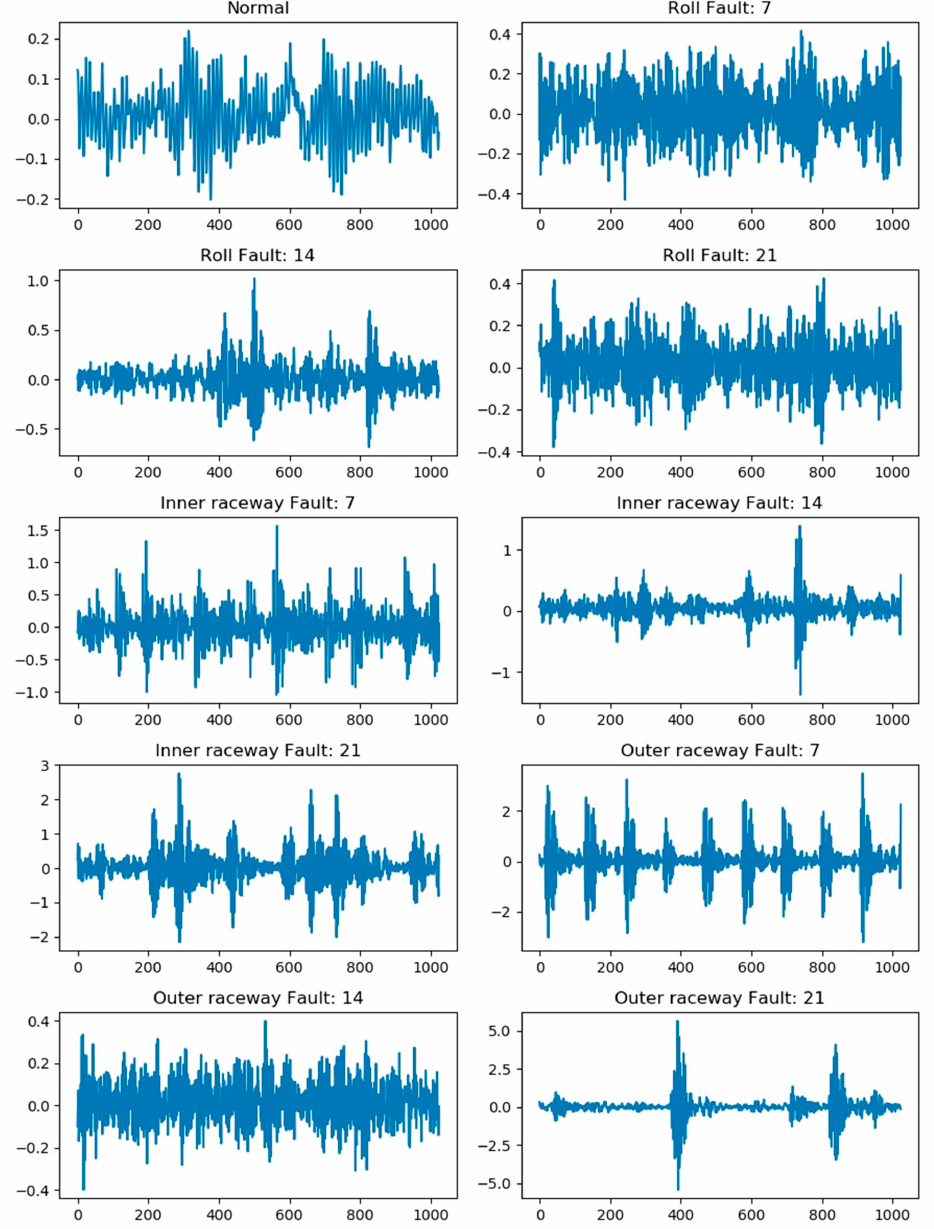
Figure 9. Time domain waveforms of ten types of bearing vibration signals